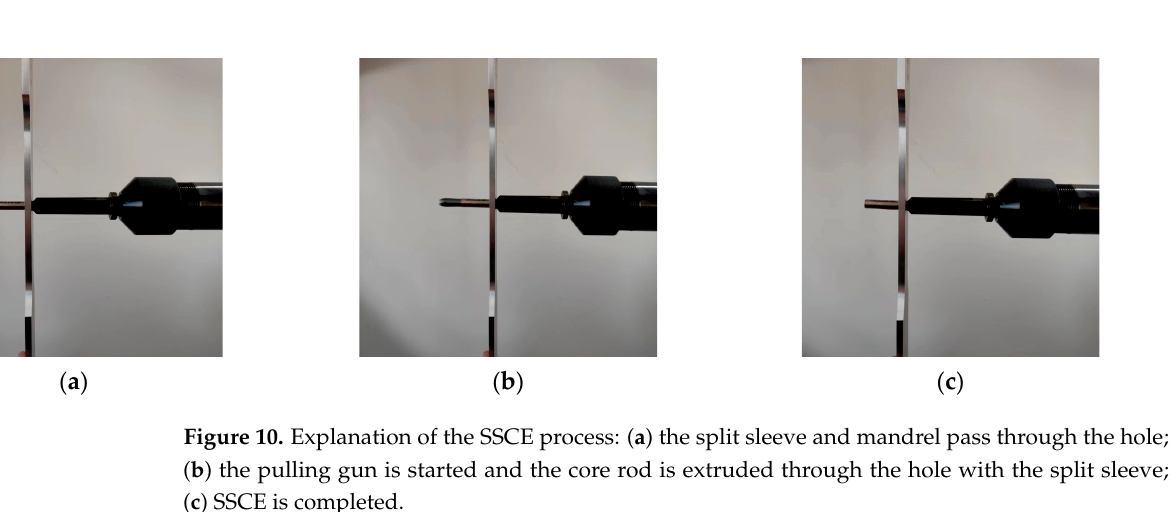
( d ) Figure 9. SSCE equipment: ( a ) oil pump; ( b ) pulls gun; ( c ) mandrel; ( d ) split sleeve.